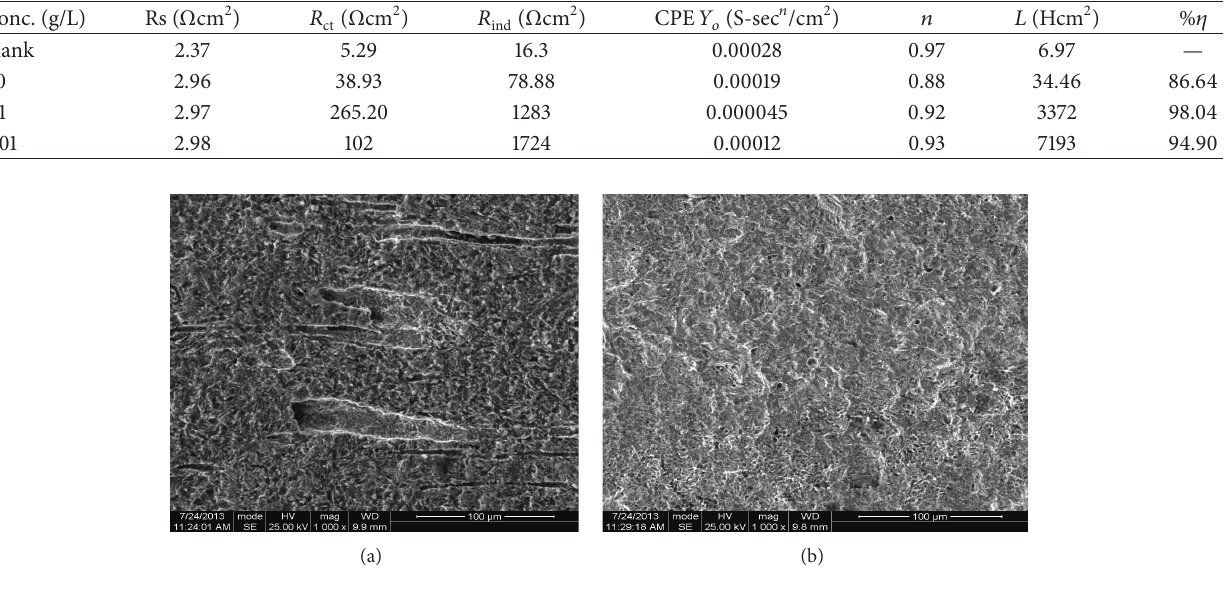
Figure 10: SEM micrograph of (a) pipeline steel in 0.5 M H 2 SO 4 and (b) pipeline steel in 0.5 M H 2 SO 4 with 0.1 g/L Brassica oleracea extract.